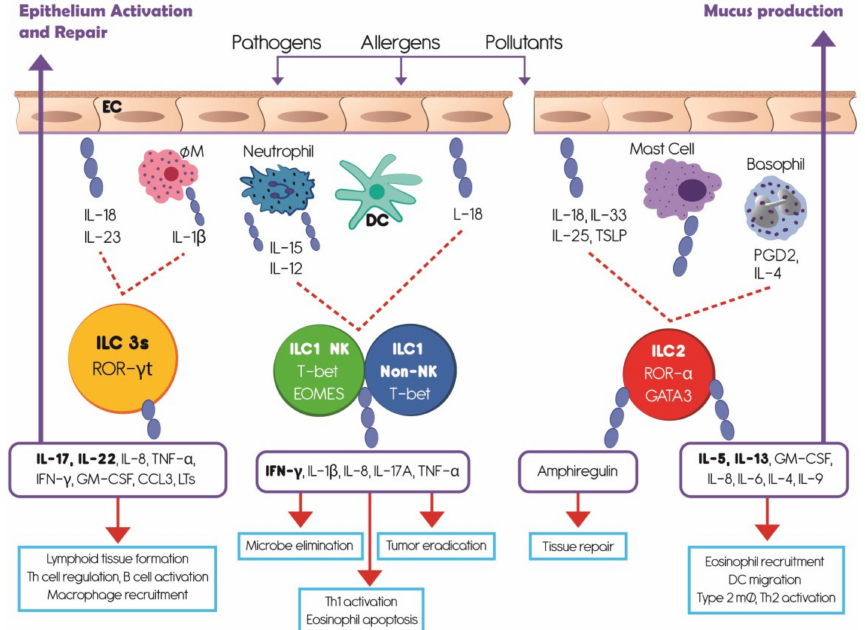
Figure 1. Summarizes the understanding of innate lymphoid cell (ILC) types, activation pathways and functions. Innate lymphoid cells are derived from a common lymphoid progenitor, have a lymphoid morphology, and lack antigen-specific receptors. Based upon the transcription factors needed for their development and the cytokines they produce, ILCs are divided in three groups which mainly populate barrier surfaces. ILC1 includes classical natural killer (NK) and non-NK cells and depends on the transcription factor T-bet. ILC2 depends on the transcription factors GATA3 and ROR α . ILC3 requires the transcription factor ROR- γ t and comprises a heterogeneous subset of cells. After external antigen contact, respiratory epithelial cells and classical innate immune cells produce several cytokines which stimulate di ff erent ILCs groups. IL-12, IL-15, IL-18 prime ILC1s to produce IFN- γ and other cytokines involved in microbe elimination, Th1 activation, and tumor eradication. ILC2s are activated by IL-4, prostaglandin D2 (PGD2), IL-33 and IL-25 to produce amphiregulin involved in tissue repair, IL-5 to recruit eosinophils, and IL-13 to stimulate mucus production by epithelial cells. ILC3s are primed by IL-18, IL-23, and IL-1 β to produce principally IL-17 and IL-22 which participate in lymphoid tissue formation, Th cell regulation, B cell activation, and epithelium activation and repair. EC, epithelial cell; MØ, macrophage; DC, dendritic cell; PGD2, prostaglandin D2; TSLP, Thymic Stromal